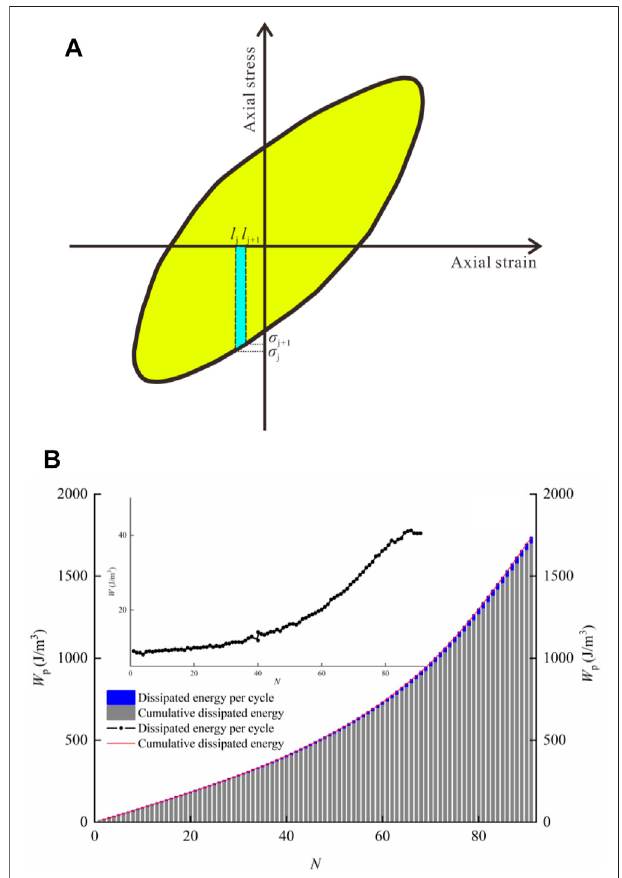
FIGURE7| Energycalculation (A) andcumulativedissipatedenergyand dissipated energy per cycle versus cycle of sample S1 (B) .